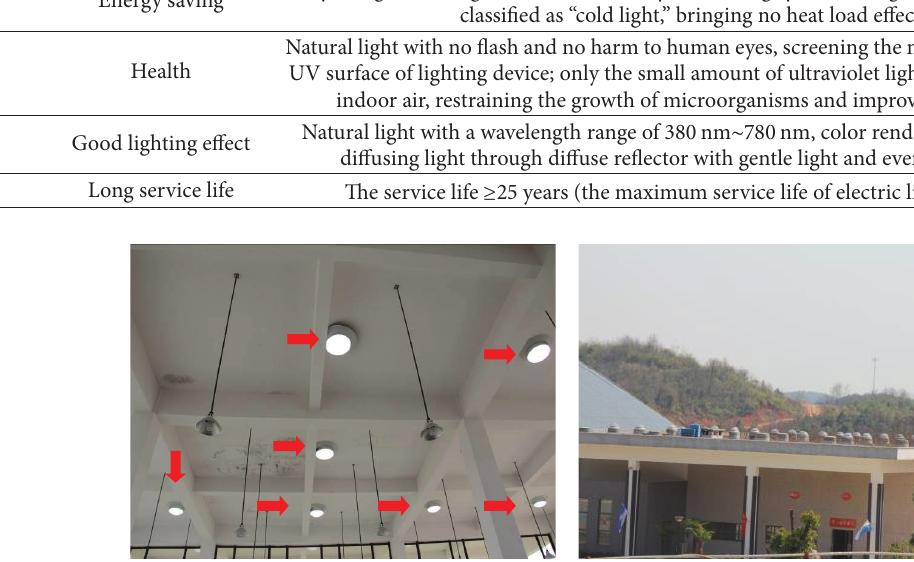
Figure 3: The natural light guidance systems in the visitor center of Lushan West Sea highway rest area.